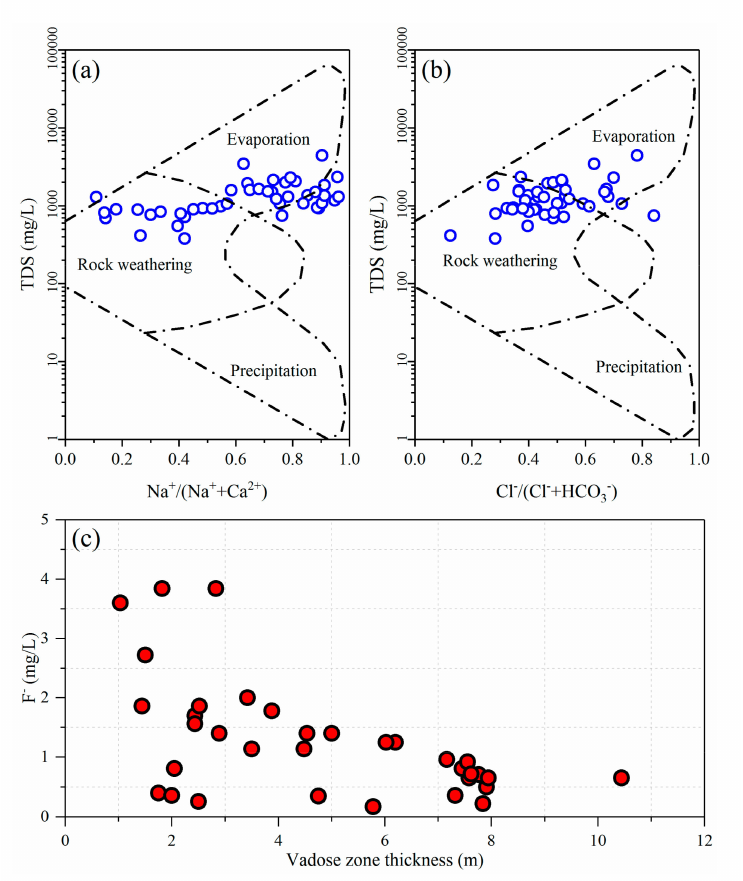
Figure 3. Influence of evaporation on fluoride in the groundwater of the Jiaolai Basin. ( a ) and ( b ) are the Gibbs diagram of groundwater, ( c ) is the relationship between F - and vadose zone